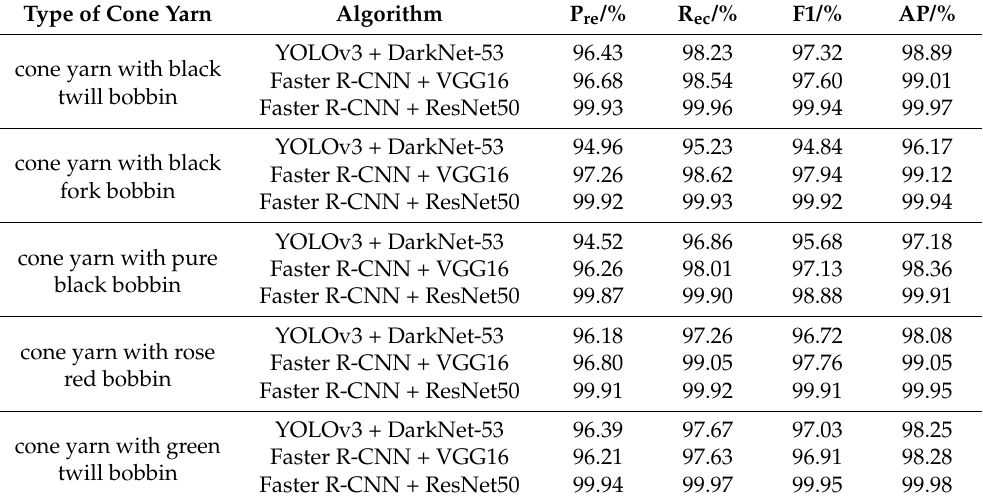
Table 2. Identification of cone yarns using different algorithms.